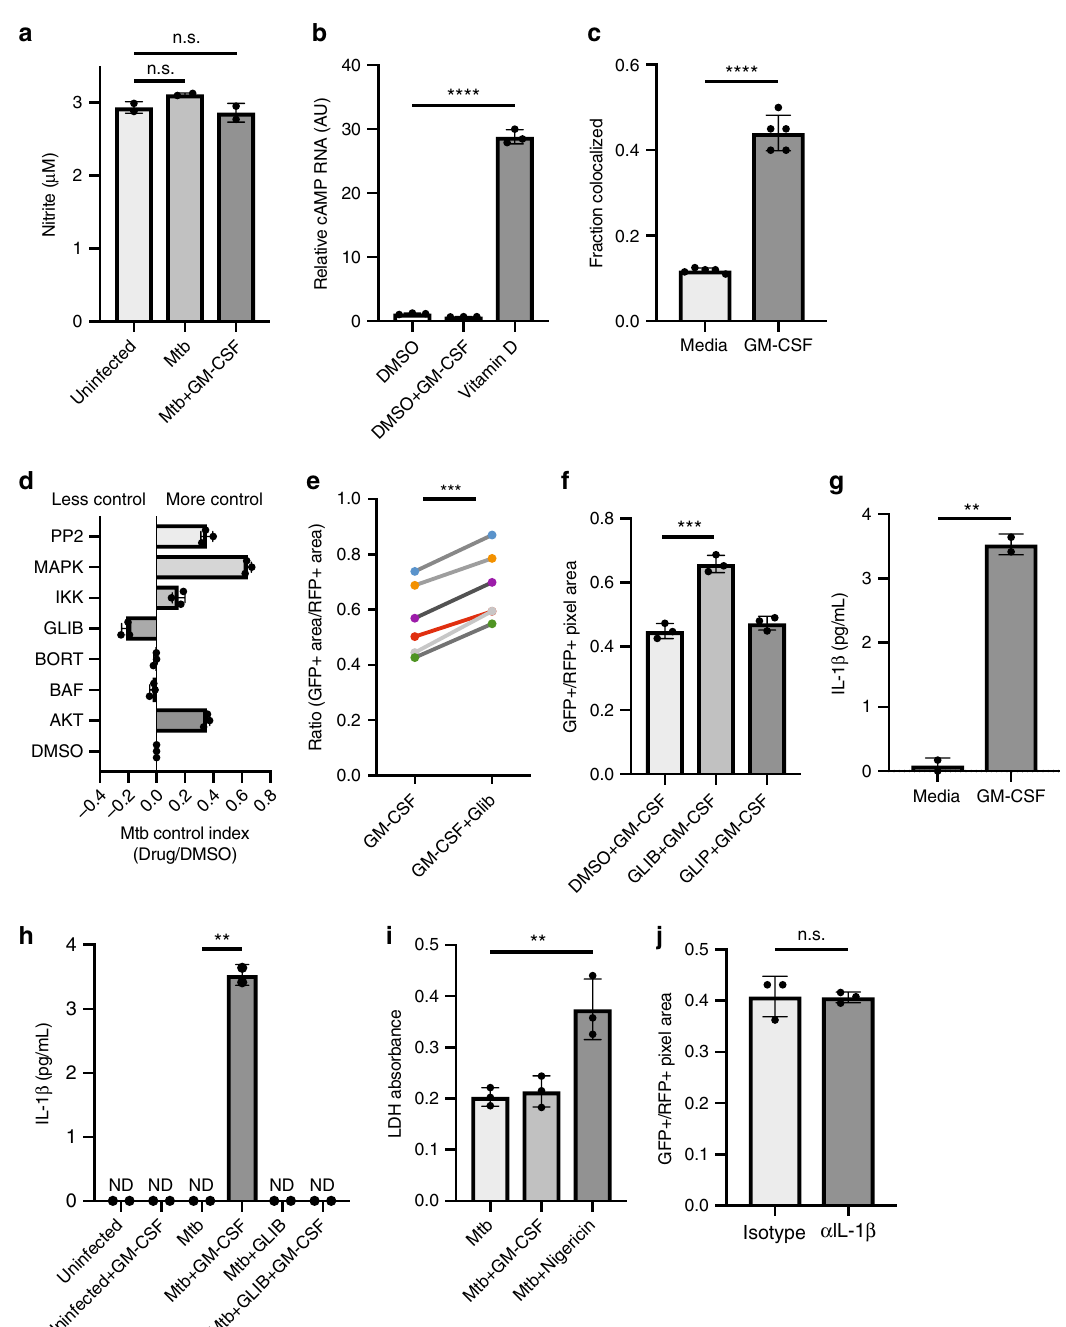
Fig. 3 GM-CSF stimulates phagolysosomal fusion and IL-1 β secretion in the absence of antimicrobial peptide production or NO production. a Nitrite production by uninfected, Mtb-infected, and GM-CSF stimulated Mtb-infected macrophages. Representative of three donors. b Quantitative PCR analysis of CAMP mRNA expression normalized to GAPDH expression in primary human macrophages were treated with GM-CSF or active Vitamin D. Each value represents the mean of ± standard deviation of three independent experiments. c Phagolysomal colocalization of GFP-Mtb with Lysotracker red was measured in 200 – 600 macrophages per well. Representative of three donors. d Small molecule GM-CSF inhibitor screen example. Bars pointing to the right identify drugs that had an increase in bacterial control while bars pointing to the left indicate a decrease in the setting of GM-CSF. e The effect of glibenclamide on GM-CSF mediated control was compared for six independent experimental donors (each donor independently color-coded). f The effect of glibenclamide or glipizide on GM-CSF mediated control was compared between vehicle-, glipizide- or glibenclamide-treated cultures. Representative of three donors. g Extracellular IL-1 β production was measured from unstimulated and GM-CSF stimulated Mtb-infected macrophages. Error bars represent standard deviation of the technical replicates. Representative of three donors. h Extracellular IL-1 β production was measured from unstimulated and GM- CSF stimulated Mtb-infected macrophages with small molecule inhibitors. Error bars represent standard deviation of the technical replicates. Representative of three donors. i LDH absorbance values in Mtb-infected macrophages with vehicle, GM-CSF or nigericin. Error bars represent standard deviation of the technical replicates. Representative of three donors. j Quanti fi cation of bacterial survival in the setting of GM-CSF with isotype or IL-1 β antibody. Error bars represent standard deviation of the technical replicates. Representative of three donors. All comparisons made using a two-tailed t -test. (ns, not signi fi cant, ** p < 0.01, *** p < 0.001, **** p < 0.0001). Source data are provided as a Source Data fi